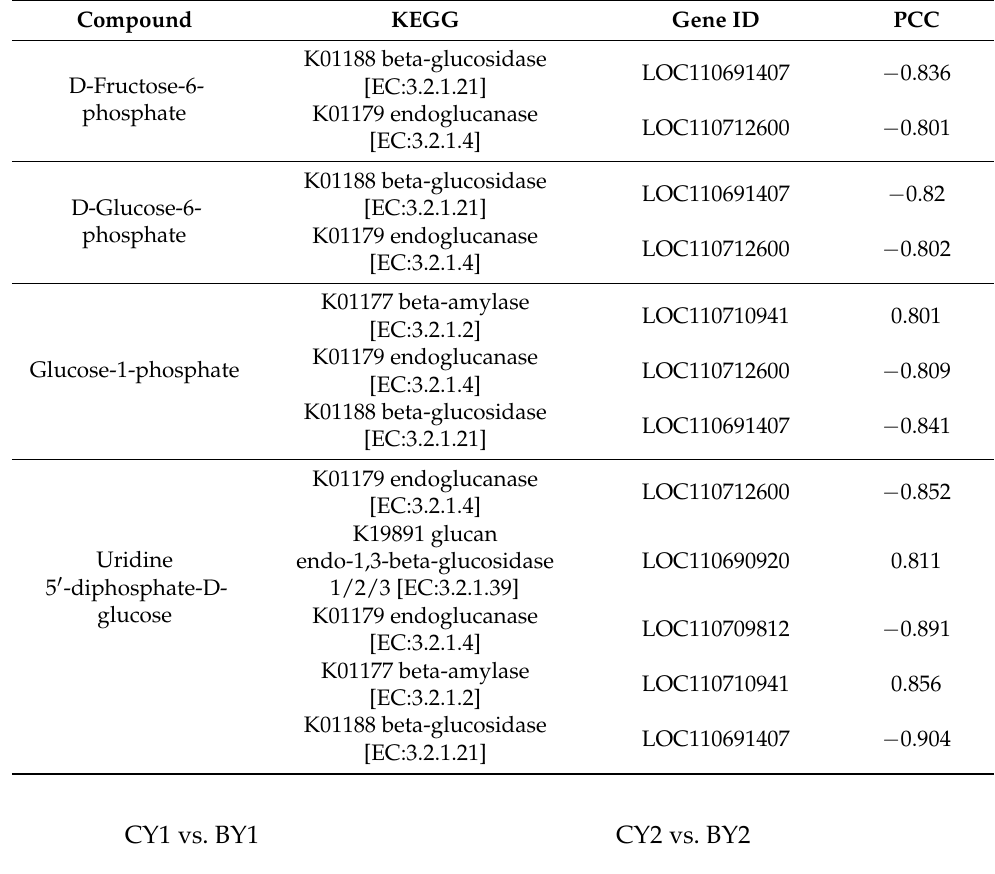
Table 3. Metabolite–gene correlations.